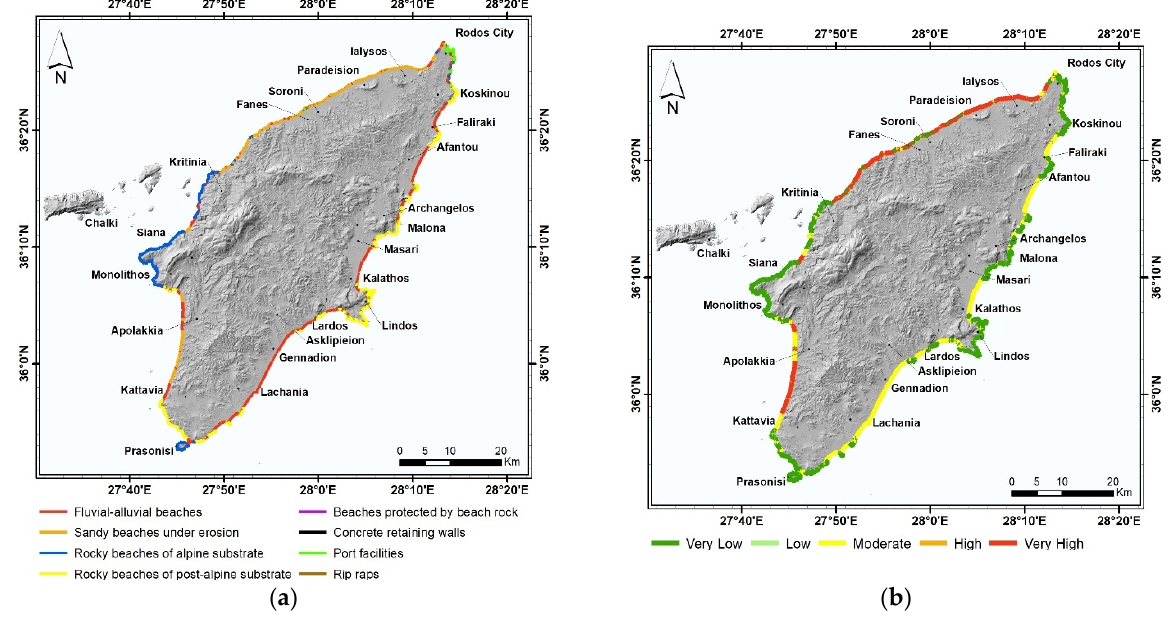
Figure 6. ( a ) Large-scale (resolution of 50 × 50 m) lithological and geomorphological features along the Rhodes Island coastal zone, determined from our field surveys during the period 2007–2013 and a literature review. ( b ) Evaluation of the relative vulnerability due to coastal geology for the present and the projected to 2100 conditions.